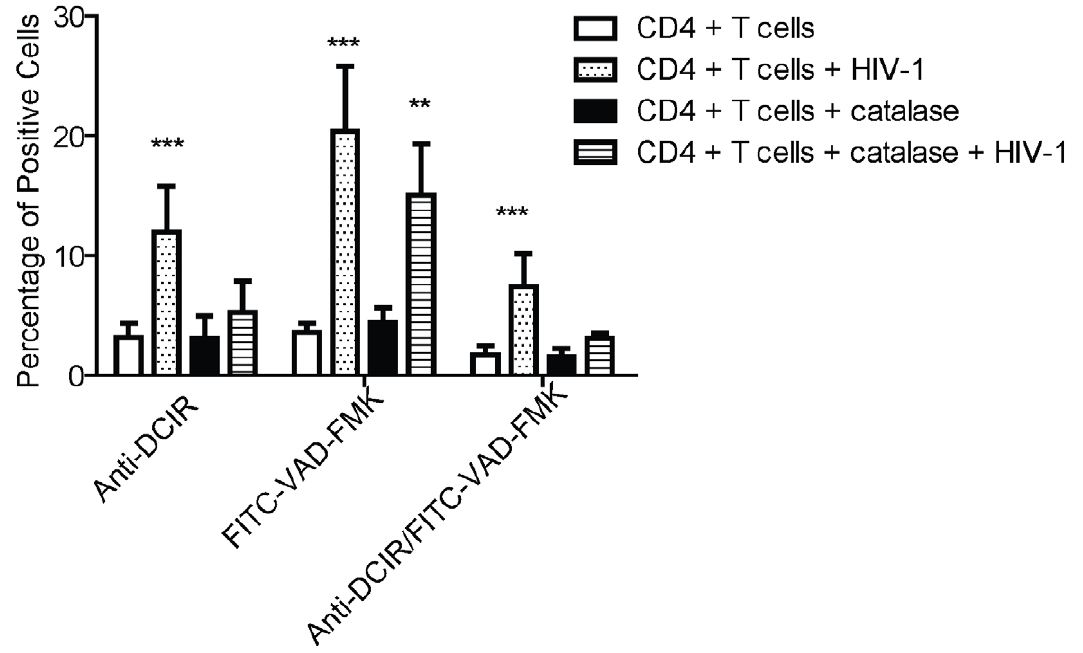
Figure 6. H 2 O 2 produced by HIV-1-infected cells promotes DCIR expression. Mitogen-stimulated CD4 + T cells (1 6 10 6 ) were either left untreated or treated with catalase before HIV-1 infection. Three days after virus infection, DCIR expression was measured by flow cytometry. Data shown represent the means 6 SD of triplicate samples from three independent experiments. Asterisks denote statistically significant data (**, P , 0.01; ***, P , 0.001).